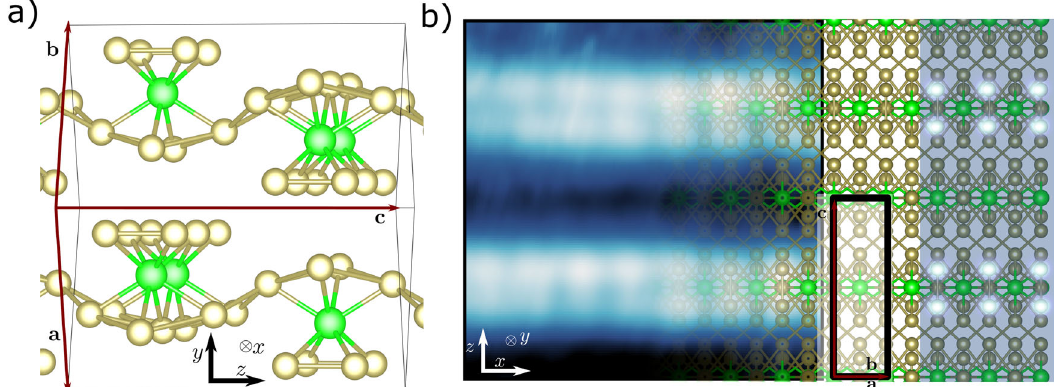
Fig. 1 Geometry of ZrTe 5 . a The considered unit cell of the crystal. The wavelike Te – Te chains run parallel to the crystallographic c direction and to the z -axis in the corresponding Cartesian coordinate system. b Atomic resolution STM image of ZrTe 5 surface. The crystal structure, from the (110) point of view, in the x − z plane is superimposed in a fading manner. The STM image calculated by DFT is overlaid on the crystal structure (right side). It highlights the Te atoms on the sample surface, which dominate the atomic resolution STM topography. STM image measured at 800 pA tunneling current, 400 mV sample bias, temperature 9 K. Table 1. Unit cell dimensions and positional parameters in fractional coordinates for ZrTe 5 as derived from the analysis of X-ray diffraction data at 300 K (calculated standard deviation in parentheses) and from relaxed DFT calculations. a [ Å ]